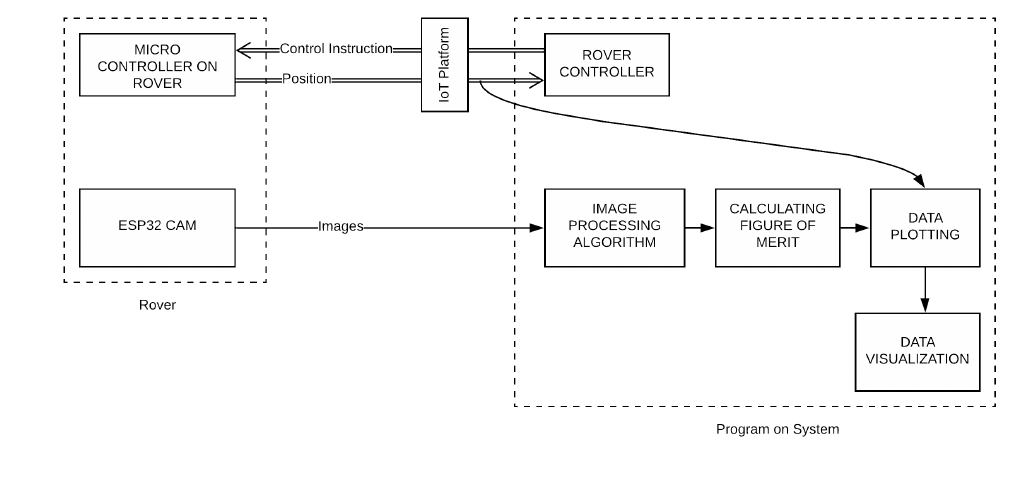
Figure 1. Block Diagram of